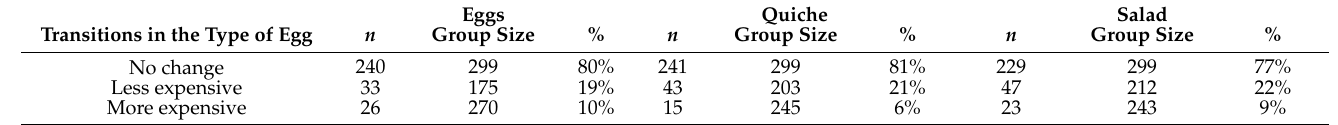
Table 7. Change from the initial choice of type of eggs, by product, after nutrition score information. Eggs Quiche Salad Transitions in the Type of Egg